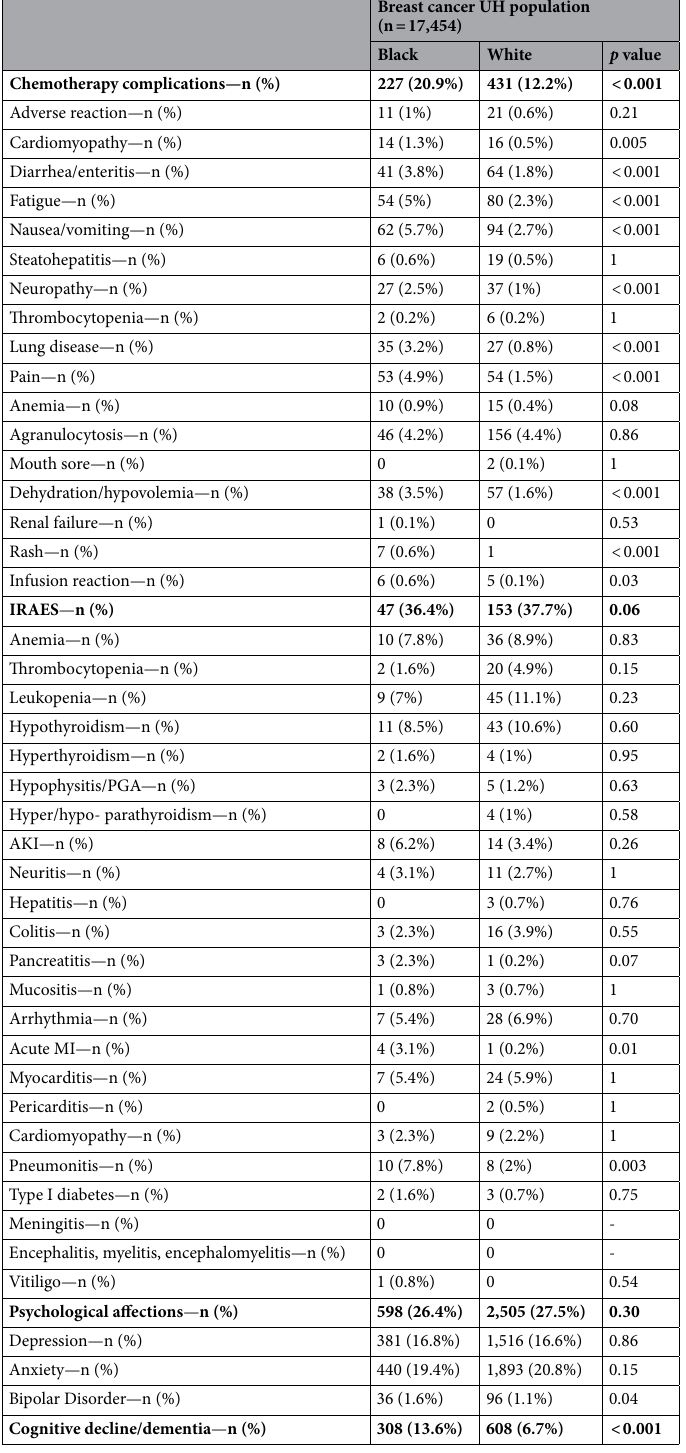
Table 3. Breast Cancer University Hospitals (UH) population (2005–2022) description and comparison stratified by race in treatment adverse events, including chemotherapy complications, irAEs (immune- related adverse events), psychological affections, and cognitive decline/dementia. IQR interquartile range; MI myocardial infarction; AKI acute kidney injury. Bold values indicates the psychological affections category is composed ofdepression + anxiety + bipolar